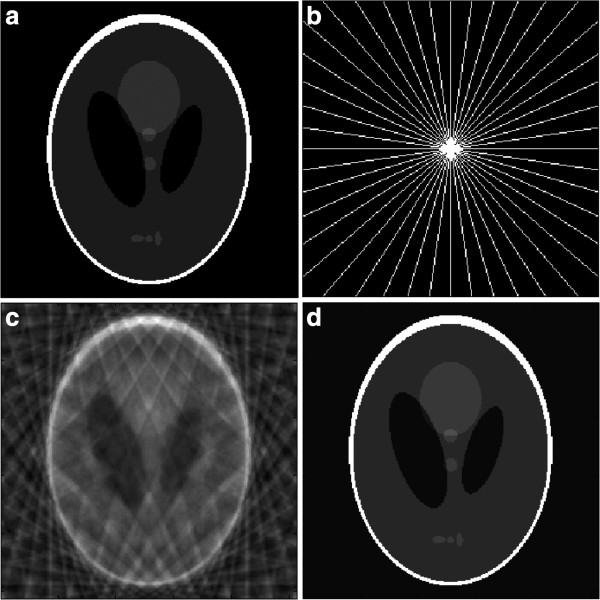
Example of a simple CS reconstruction problem. (a) The Shepp-Logan phantom test image. (b) The sampling geometry from which Fourier coefficients are sampled along 22 approximately radial lines. (c) The zero-filling result, where non-sampled coefficients are set to zero and an inverse Fourier transformation is applied. (d) Reconstruction obtained using CS methods. The reconstruction is an exact replica of the image in (a). We also tested all sampling geometries of Table
1 on this image. For sampling geometries using 20.3% of the total samples, reconstructions gave values well-above 40 dB (50-60 dB) which are excellent (e.g., see Figure
5). It is interesting to note that stochastic geometries perform significantly better than deterministic geometries at higher sampling rates. For example, random sampling on PDF gave over 90 dB reconstructions while the SLP geometry gave reconstructions of less than 60 dB. Again, all of these reconstructions are excellent. The lack of perfect-reconstruction for our geometries comes from the use of Wavelet transform in our method. As it is well-known, and also demonstrated here, the standard TV-norm is the best fit for this example.